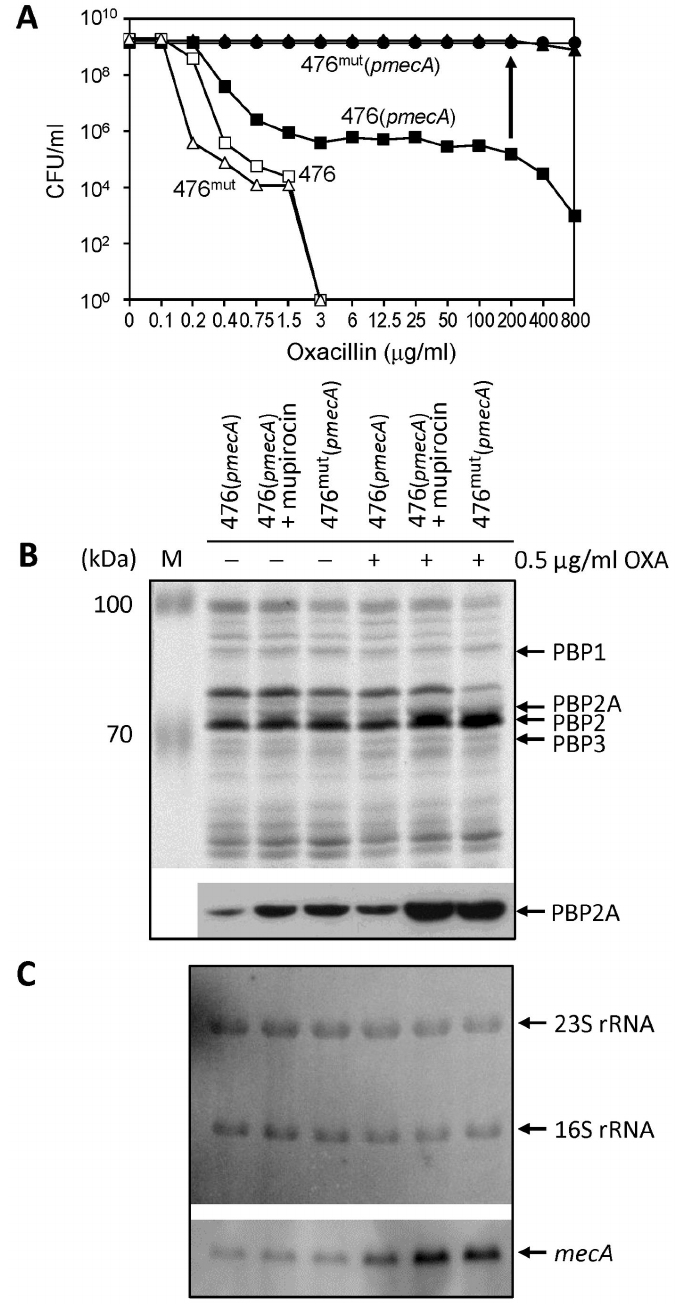
Figure 1. Correlation between oxacillin resistance and the level of transcription and translation of mecA – in the 476(pmecA) model system. ( A ) Susceptibility of strains and constructs to oxacillin was determined by population analysis. Population Analysis Profiles (PAPs) are shown for the following: MSSA strain 476 (□); 476(pmecA) (■) (strain 476 carrying plasmid borne copies of mecA ); 476 mut (pmecA) (▲) (culture of a highly resistant colony picked from agar containing 200 µg/ml oxacillin); 476 mut ( △ ) (derivative of 476 mut (pmecA) “cured” of the plasmid–borne mecA ); 476(pmecA)“induced” (●) (476(pmecA) plated on oxacillin containing agar supplemented with 0.03 µg/ml mupirocin). ( B ) SDS-PAGE analysis of membranes isolated from strain 476 and its derivatives. The relative amounts of PBP2A were determined by Western Blotting using a monoclonal antibody prepared against PBP2A. Expression of PBP2A was induced in 476(pmecA) by oxacillin (lanes 4-6). “M” indicates molecular size marker. ( C ) Northern blotting was used to assay transcription of mecA . Transcriptions of 16S and 23S rRNA were used as controls. doi: 10.1371/journal.pone.0082814.g001 PLOS ONE |